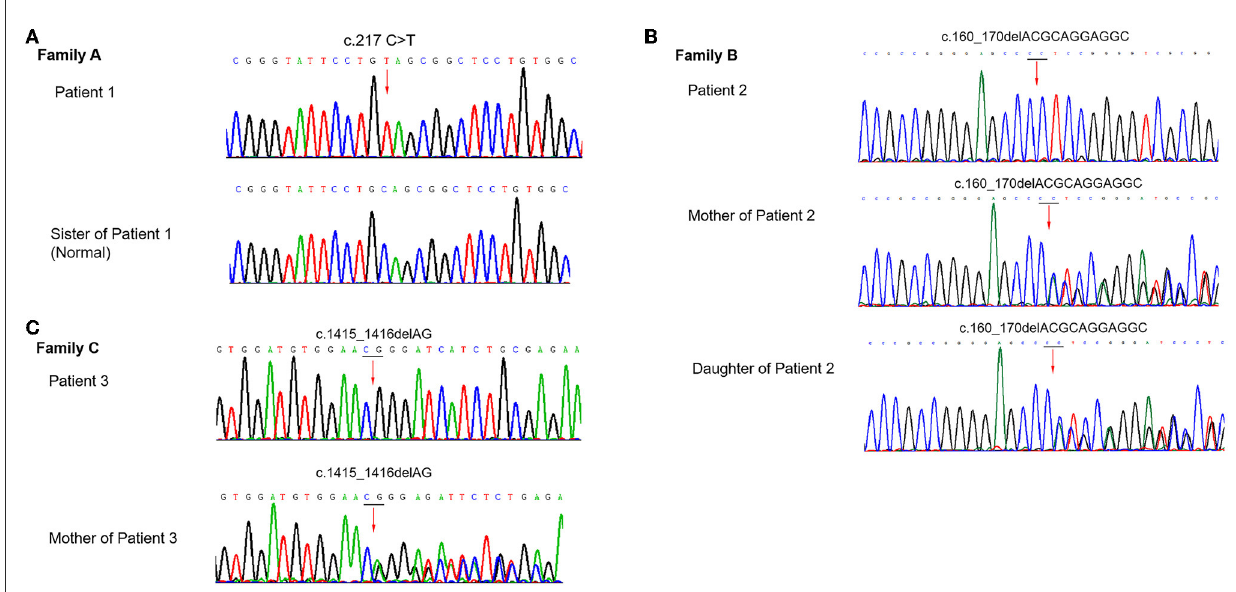
FIGURE3 Sanger sequencing results of the ABCD1 gene in the probands and their families. (A) Family A: Patient 1 was with mutation c.217 C > T. (B) Family B: Patient 2, his mother, and daughter were with the mutation c.160_170delACGCAGGAGGC. (C) Family C: Patient 3 and his mother were with the mutation c.1415_1416delAG.